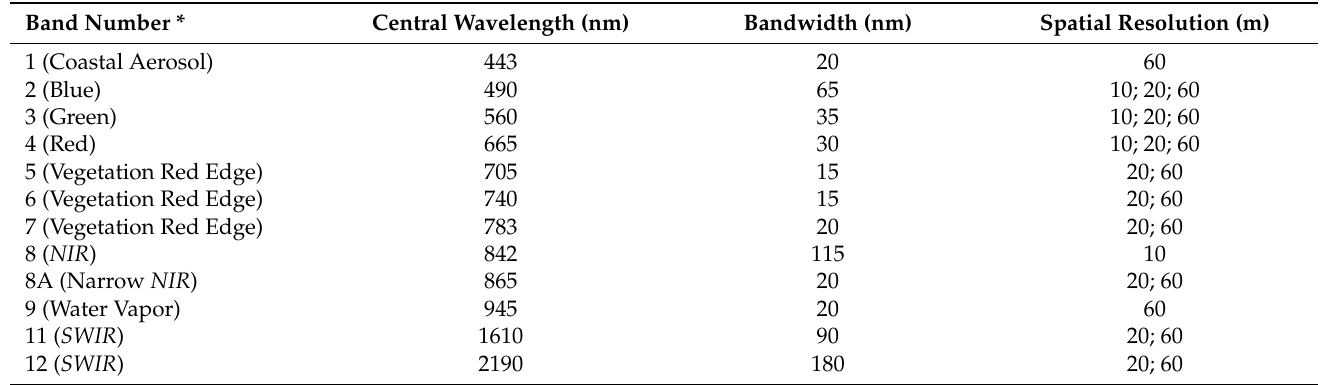
Table 1. Sentinel-2 satellite data technical specifications